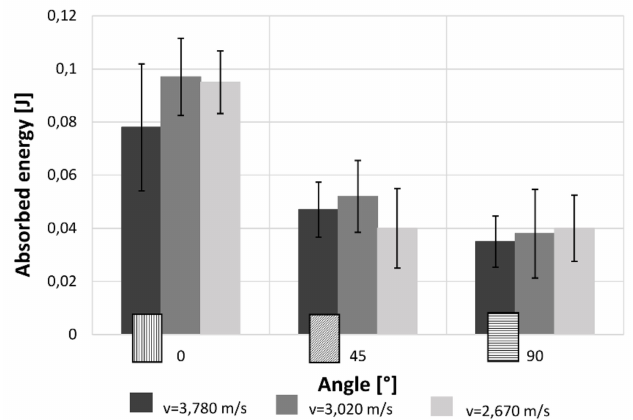
Figure 9. E ff ect on the absorbed energy of the raster angles and impact speeds for single-layer specimens.